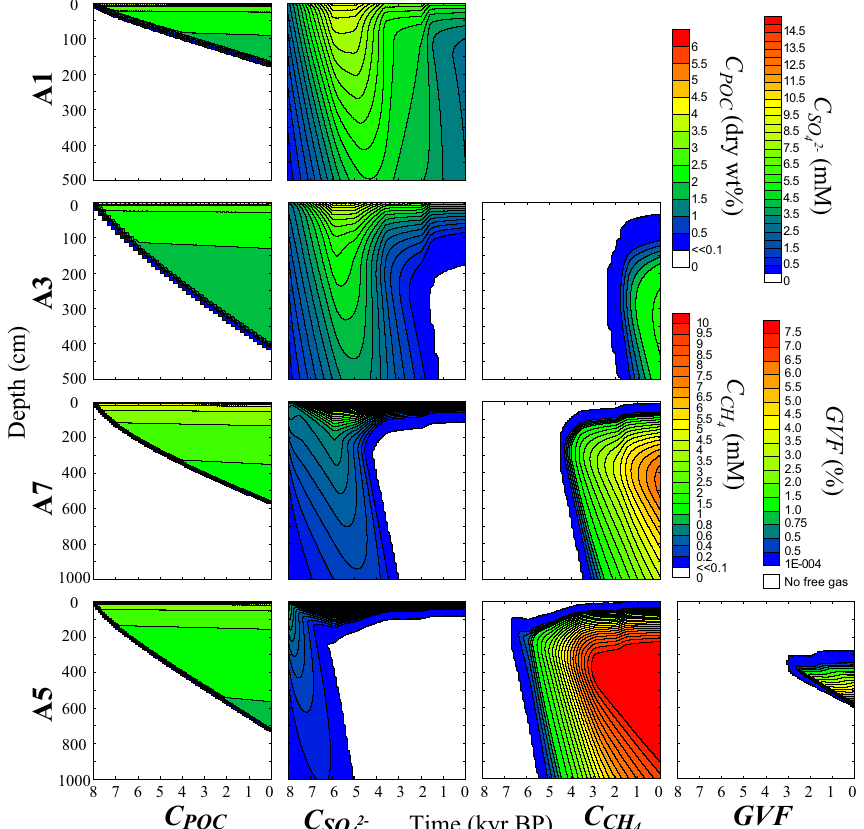
Fig. 8. Temporal changes of (where applicable) POC concentration (dry wt. %), sulphate (mM), methane (mM) and gas volume fraction (GVF, %) at Stations A1, A3, A7 and